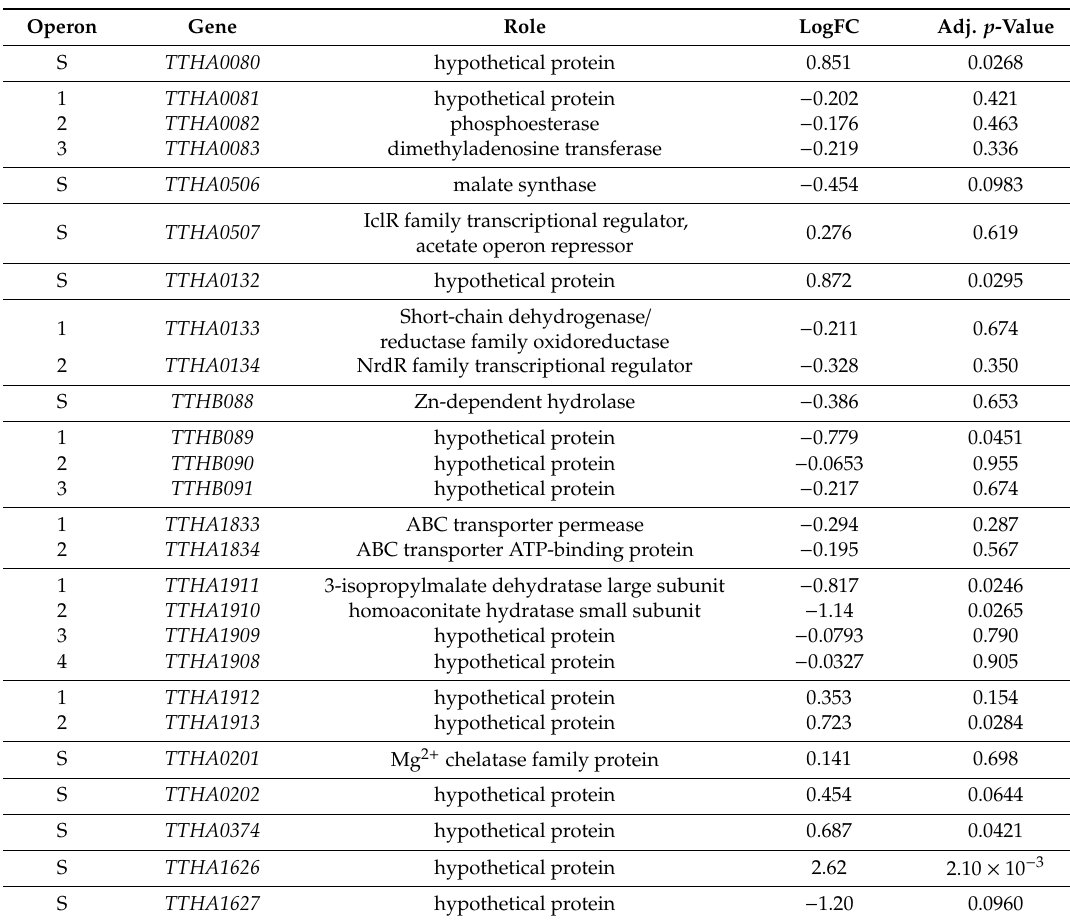
Table 4. Expression profile data of the FIMO identified operons in a TTHB099-deficient strain of T. thermophilus